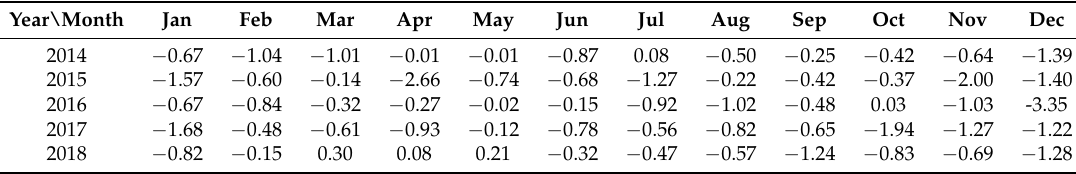
Table A10. Monthly minimums for sea surface height for the years